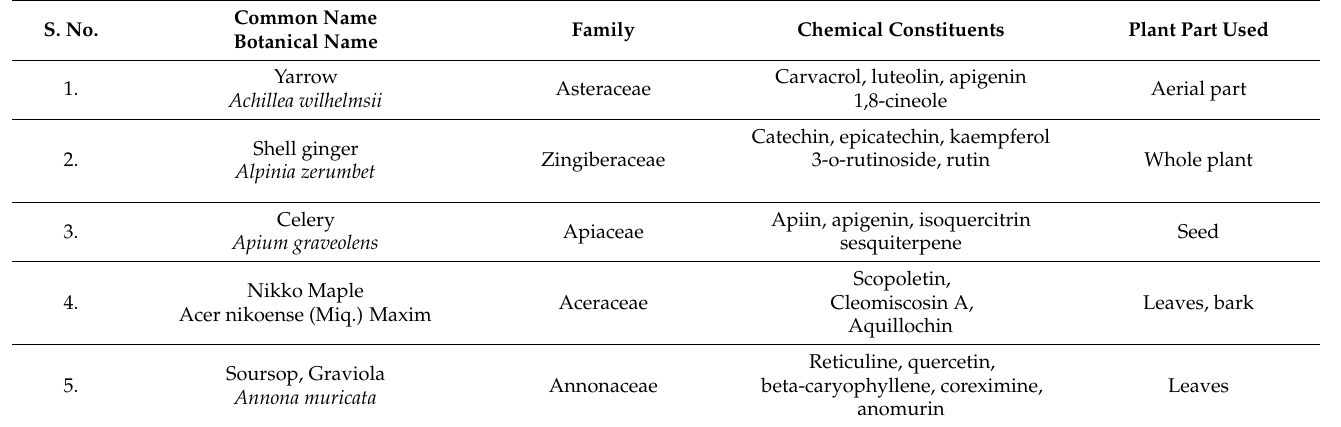
Table 1. Medicinal plants and their botanical names, chemical constituents responsible for activity, and the type of extracts